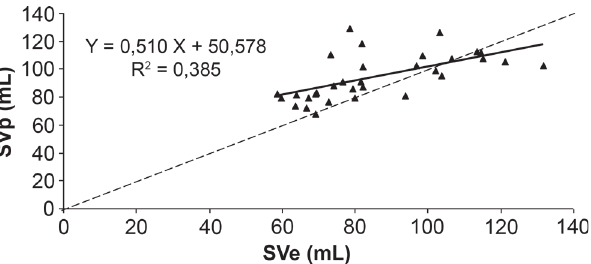
Fig 9. Correlation plots between SVe and SVp computed with the Windkessel algorithm. —— : equality